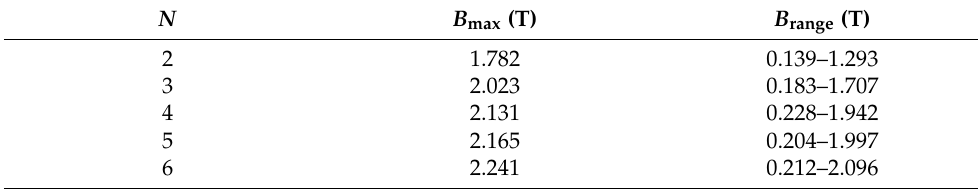
Table 3. The B max and B range by multiphysics for the various number of coil turns ( N